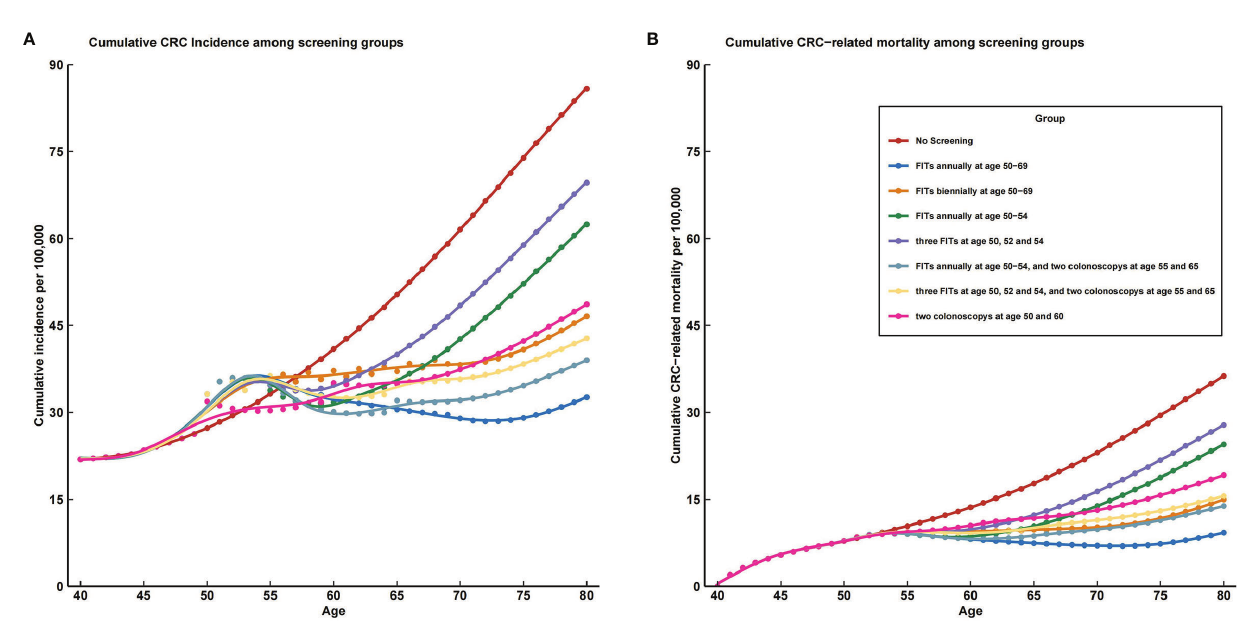
FIGURE 4 | The prevalence trends of colorectal cancer incidence and mortality in all screening strategies compared with no screening. CRC, colorectal cancer; FIT, fecal immunochemical test. (A) cumulative CRC incidence among screening groups; (B) cumulative CRC related mortality among screening